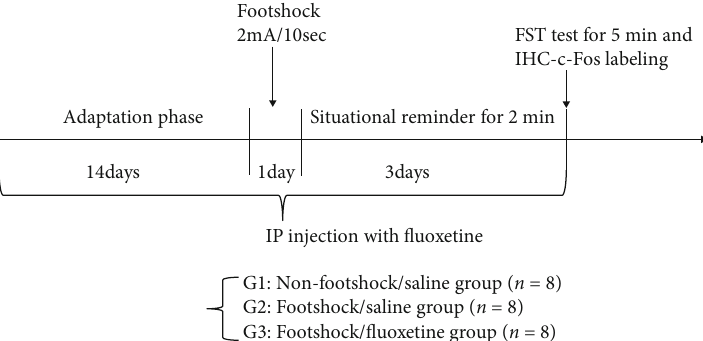
Figure 1: The experimental procedure. After the 14-day adaptation phase, a 2-mA footshock for 10 seconds was applied for fear conditioning, and the freezing time was measured for 2 min during one session a day in the situational reminder sessions. Later, the mice ’ s fl oating behavior was measured for 5 min in the FST. Following the fi nal session of freezing and fl oating behavior measurements, 120 mice were sacri fi ced, and their brain tissues were labeled using immunohistochemical staining with c-Fos